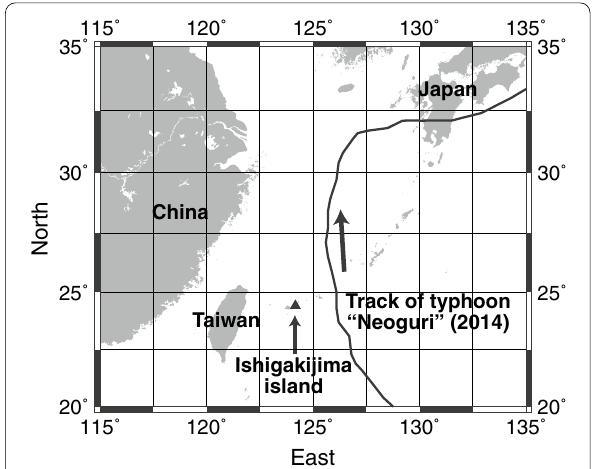
Fig. 1 Location of Ishigakijima island, Japan, where the superconducting gravimeter CT #036 is installed. The track of the typhoon “Neoguri” (2014) is also